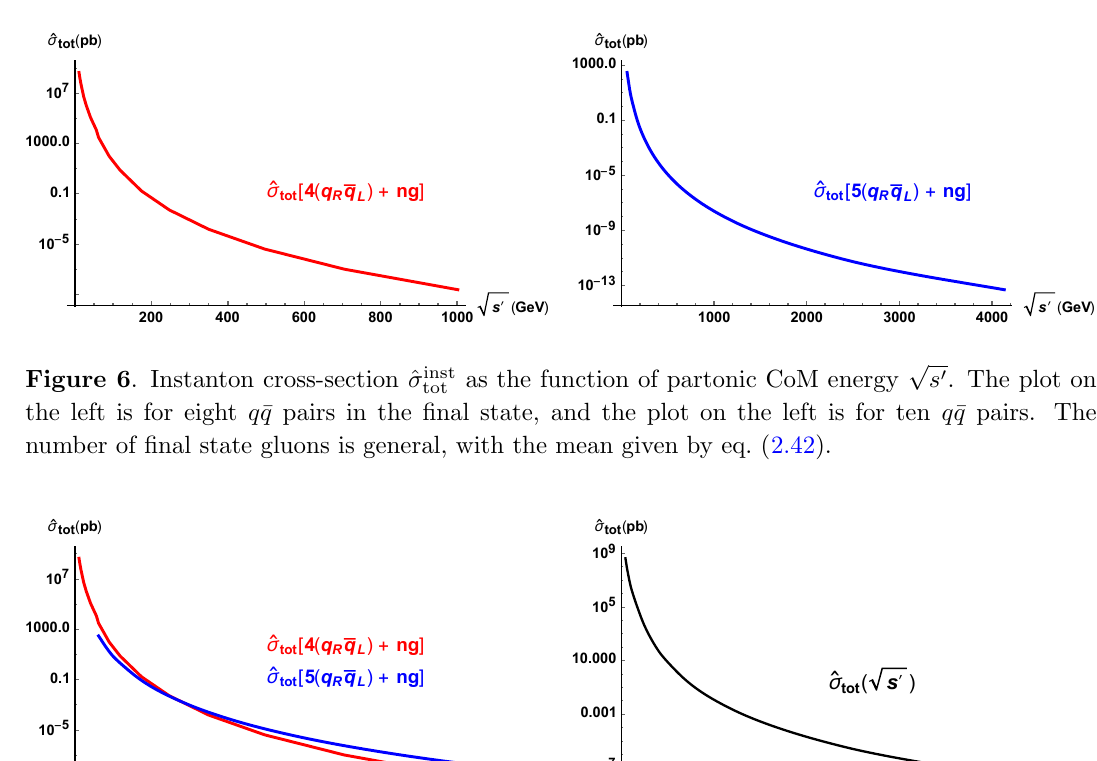
Figure 7 . Instanton cross-section as the function of partonic CoM energy left shows ^ (cid:27) inst for eight q (cid:22) q pairs in the (cid:12)nal state (in red) and for ten q (cid:22) q pairs (in blue). The sum tot of these two contributions to the total cross-section is shown on the right plot. The mean number of (cid:12)nal state gluons varies with energy and can be read from the right plot in (cid:12)gure 5.